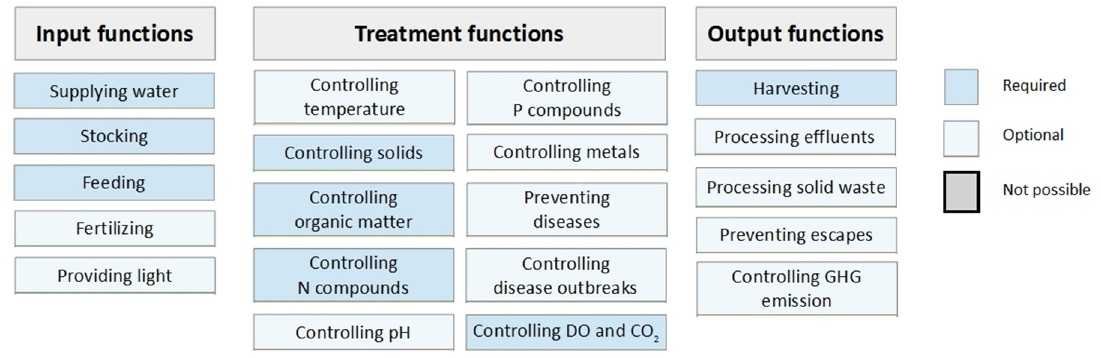
Figure 5. The system map describing intensive aquaculture systems.